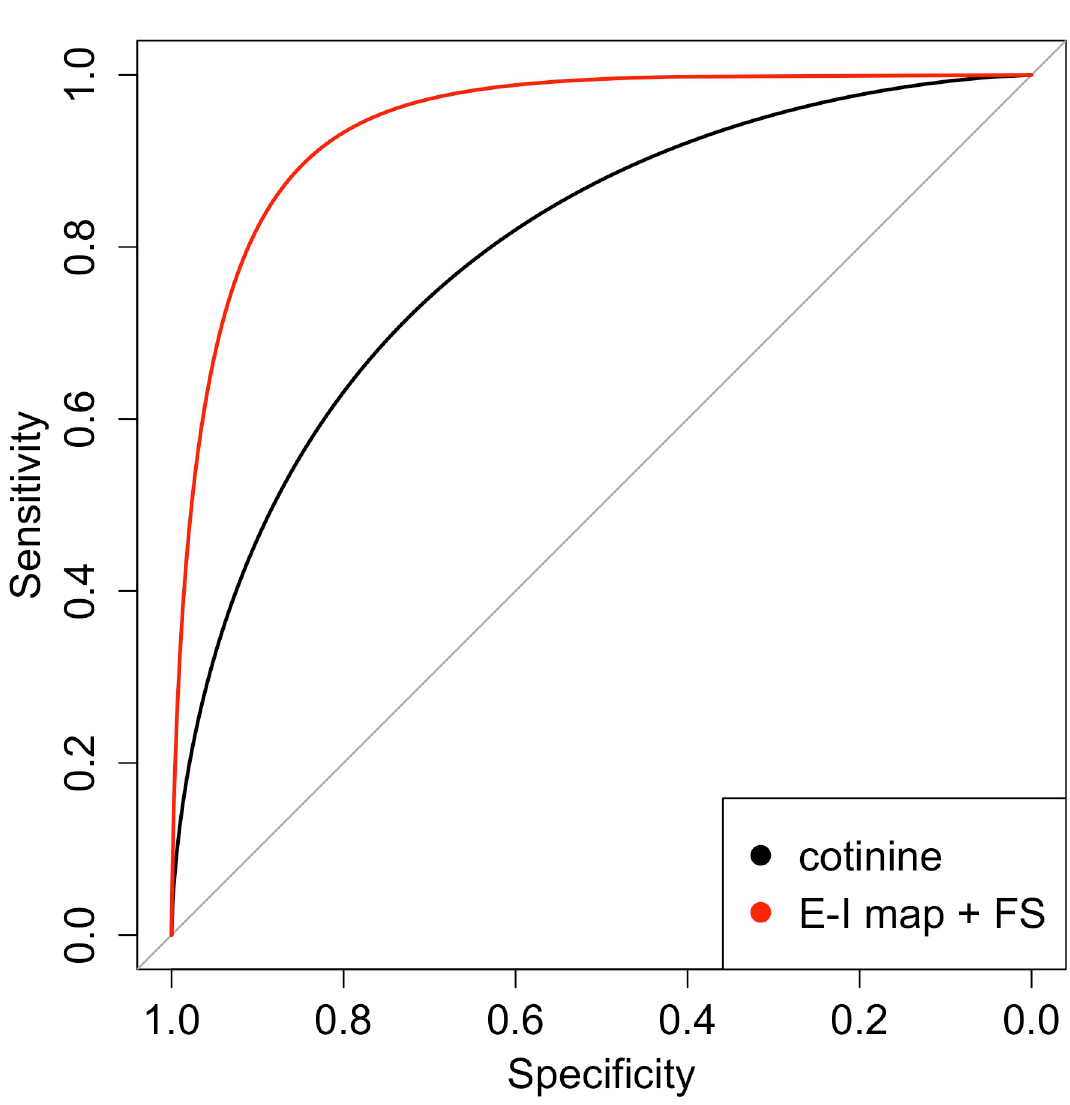
Fig 5. ROC curves in test data for the serum cotinine (black) and the exon model including the (Exon-to-)isoform map layer and feature selection layer (red) which has significantly better performance (Delong test p =